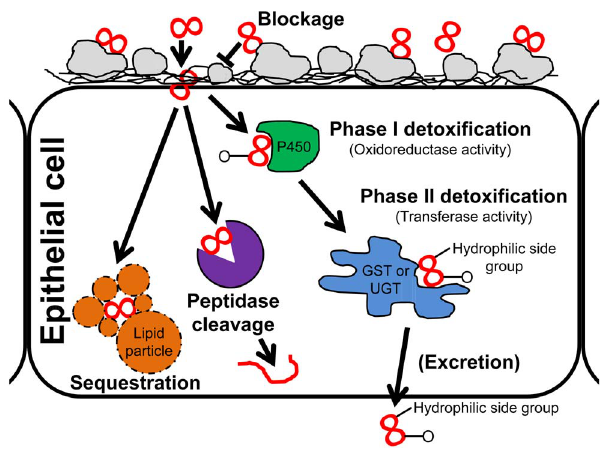
Figure 7. A model of the four mechanisms that contribute to the resistance to a -amanitin in concert. The bicyclic octapeptide a - amanitin is shown as a red 8. Cuticular proteins block some of the a - amanitin from entering the cells (blockage). a -Amanitin that entered the cytoplasm is either sequestered in lipid particles, cleaved by peptidases, or detoxified by phase I and II detoxification enzymes, possibly followed by excretion.